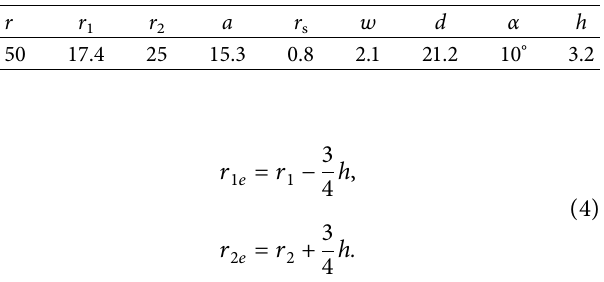
Figure 1: Configuration of the proposed wideband patch antenna. Table 1: Structural parameters of the antenna (unit: